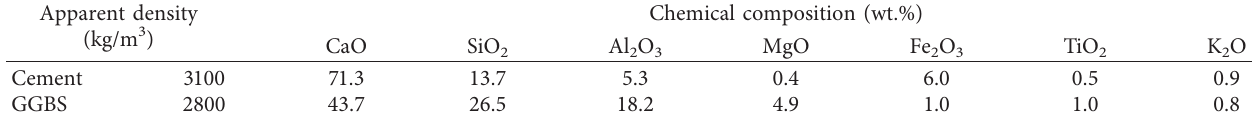
Table 1: Apparent density and chemical composition of cement and